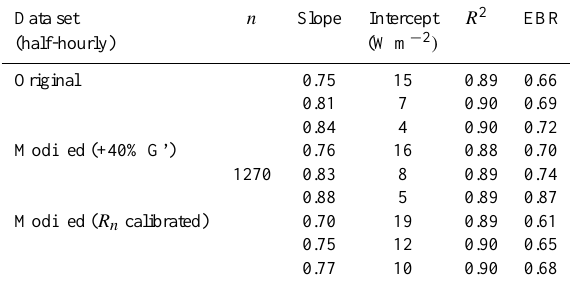
Table 2. Parameters of the linear regression between the turbulent flux (H+LE) and the available energy, as well as the Energy Balance Ratio (EBR), for the entire original dataset, and assuming G 0 and R n underestimation. For each case the available energy considered is: R n -G’(top line), R n -G (middle line), and R n -G-S (bottom line). Data